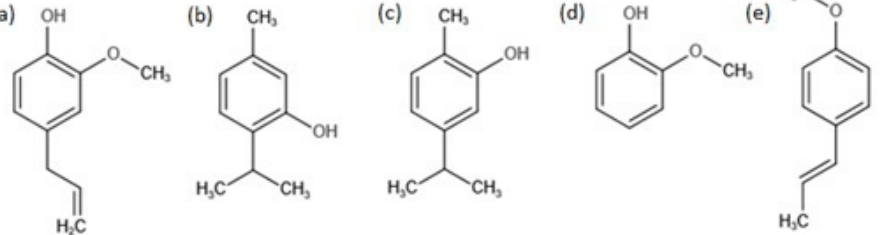
Figure 1. Chemical structure of eugenol ( a ), thymol ( b ), carvacrol ( c ), guaiacol ( d ), and trans-ane- anethol ( e thol ( e ).